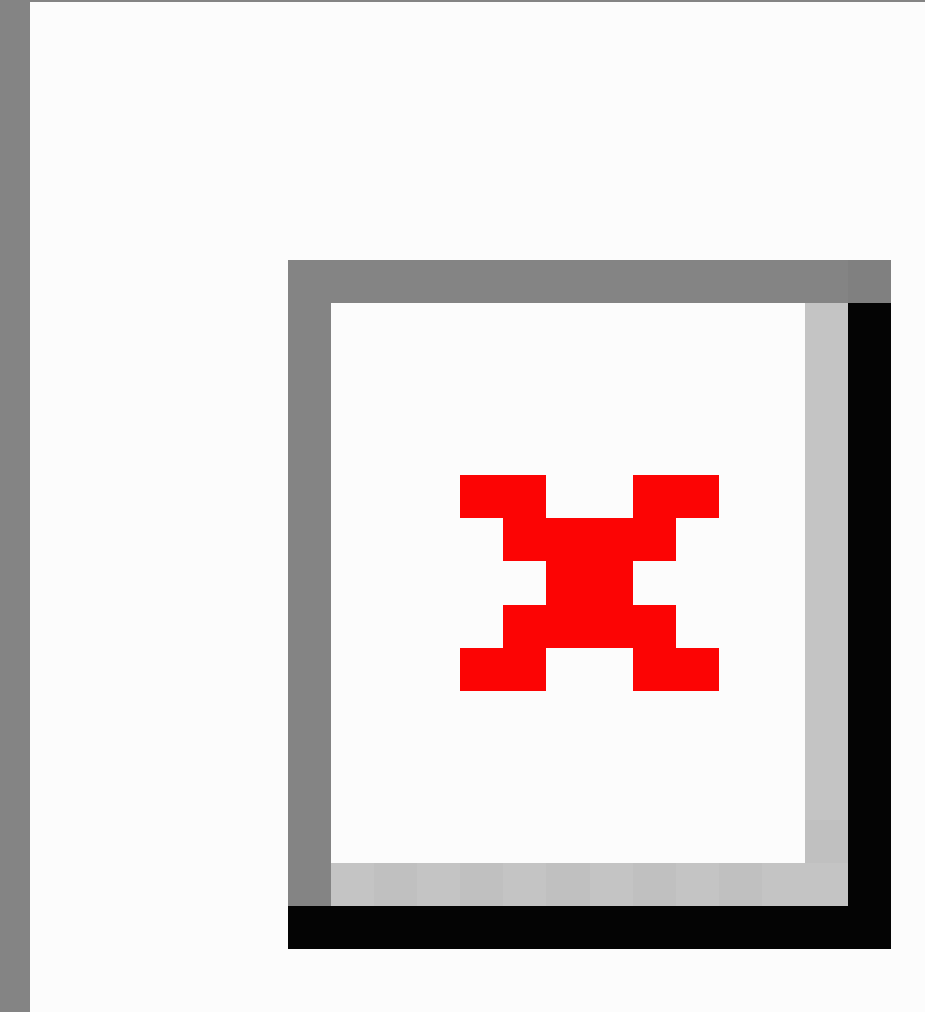
Figure 12. E Couch navigation